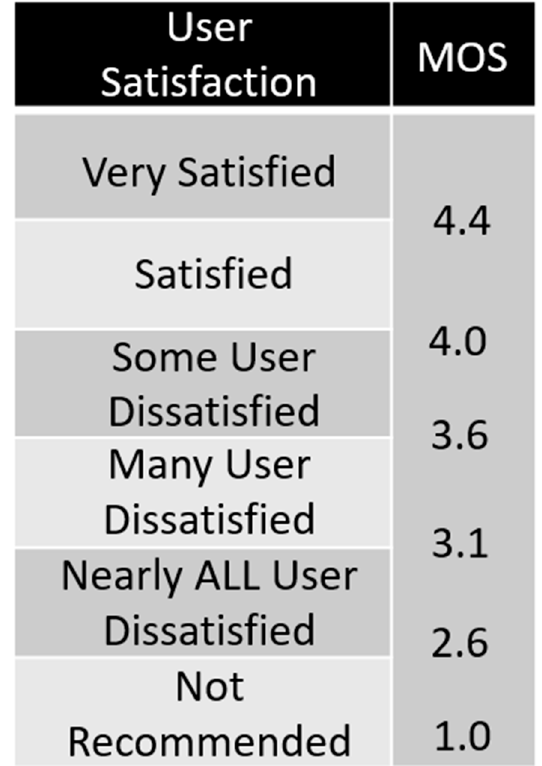
Figure 9. PESQ Quality Chart.